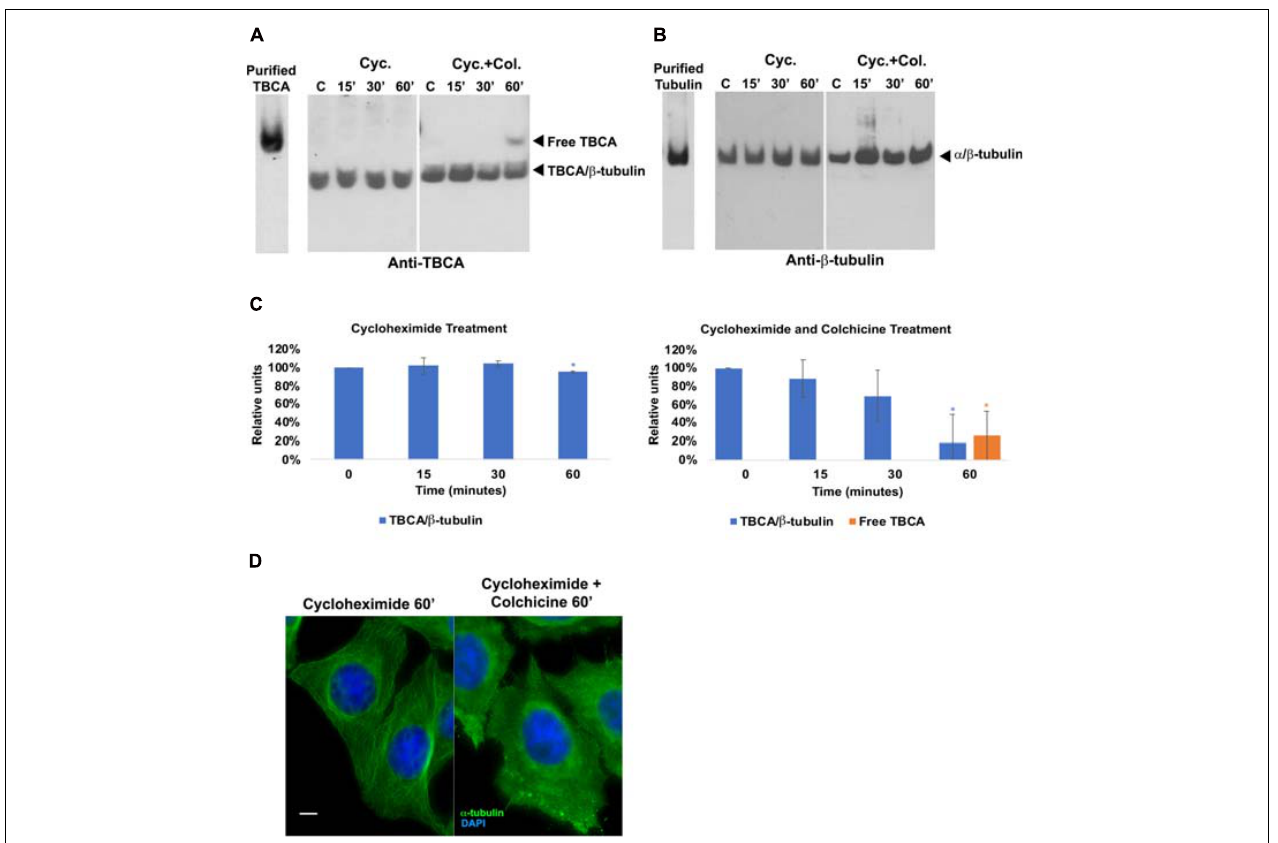
FIGURE 2 | Protein translation inhibition by cycloheximide does not lead to the detection of free TBCA in the cell extract. HeLa cells were treated with cycloheximide to inhibit the protein translation and also with cycloheximide plus colchicine for 15, 30, and 60 min. In both treatments, time 0 min (control) corresponds to 15 min after the cycloheximide addition. After each treatment, native protein extracts were prepared, and equal amounts of soluble protein (30 µ g) were analyzed by non-denaturing gel electrophoresis (6% Native-PAGE) followed by western blot with antibodies directed to TBCA (A) and β -tubulin (B) . Representative images of the native-PAGE show that under the cycloheximide treatment, free TBCA was not detected, and the levels of TBCA/ β -tubulin are maintained but, the addition of colchicine to cycloheximide leads to a decrease in TBCA/ β -tubulin levels and detection of free TBCA after 60 min of colchicine treatment ( A,C : for cycloheximide treatment * p < 0.005, and for cycloheximide and colchicine treatment * p < 0.002). The graphs in panel (C) (cycloheximide and cycloheximide plus colchicine), show the relative units in percentage of TBCA/ β -tubulin complex and free TBCA levels in comparison to control (100%) cells. Statistical significance was calculated using a t -test. And the p -values were determined in comparison to the time 0 min (control). The graphic bars are the mean s.d. (error bars) of three independent assays. The α / β -tubulin levels are maintained during cycloheximide treatment but increase after addition of colchicine (B) . For each treatment, the MT depolymerization was confirmed by indirect immunofluorescence (D) using an antibody against α -tubulin (the DNA was stained with DAPI, scale bar 10 µ m). The results observed in panel (B) agree with the results showed in panel (C) , where MTs can be detected with cycloheximide treatment but not with cycloheximide plus colchicine (C)